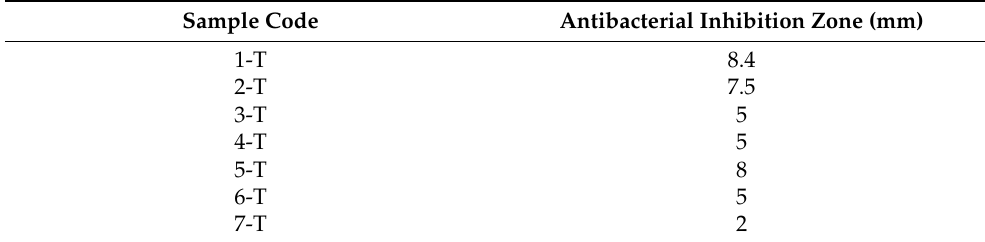
Figure 6. Digital photos of the clear antibacterial inhibition zone for different coated cotton hand embroidery threads presented from 1 to 7-T as T refers to treated threads. Table 3. Antibacterial properties of coated cotton threads.